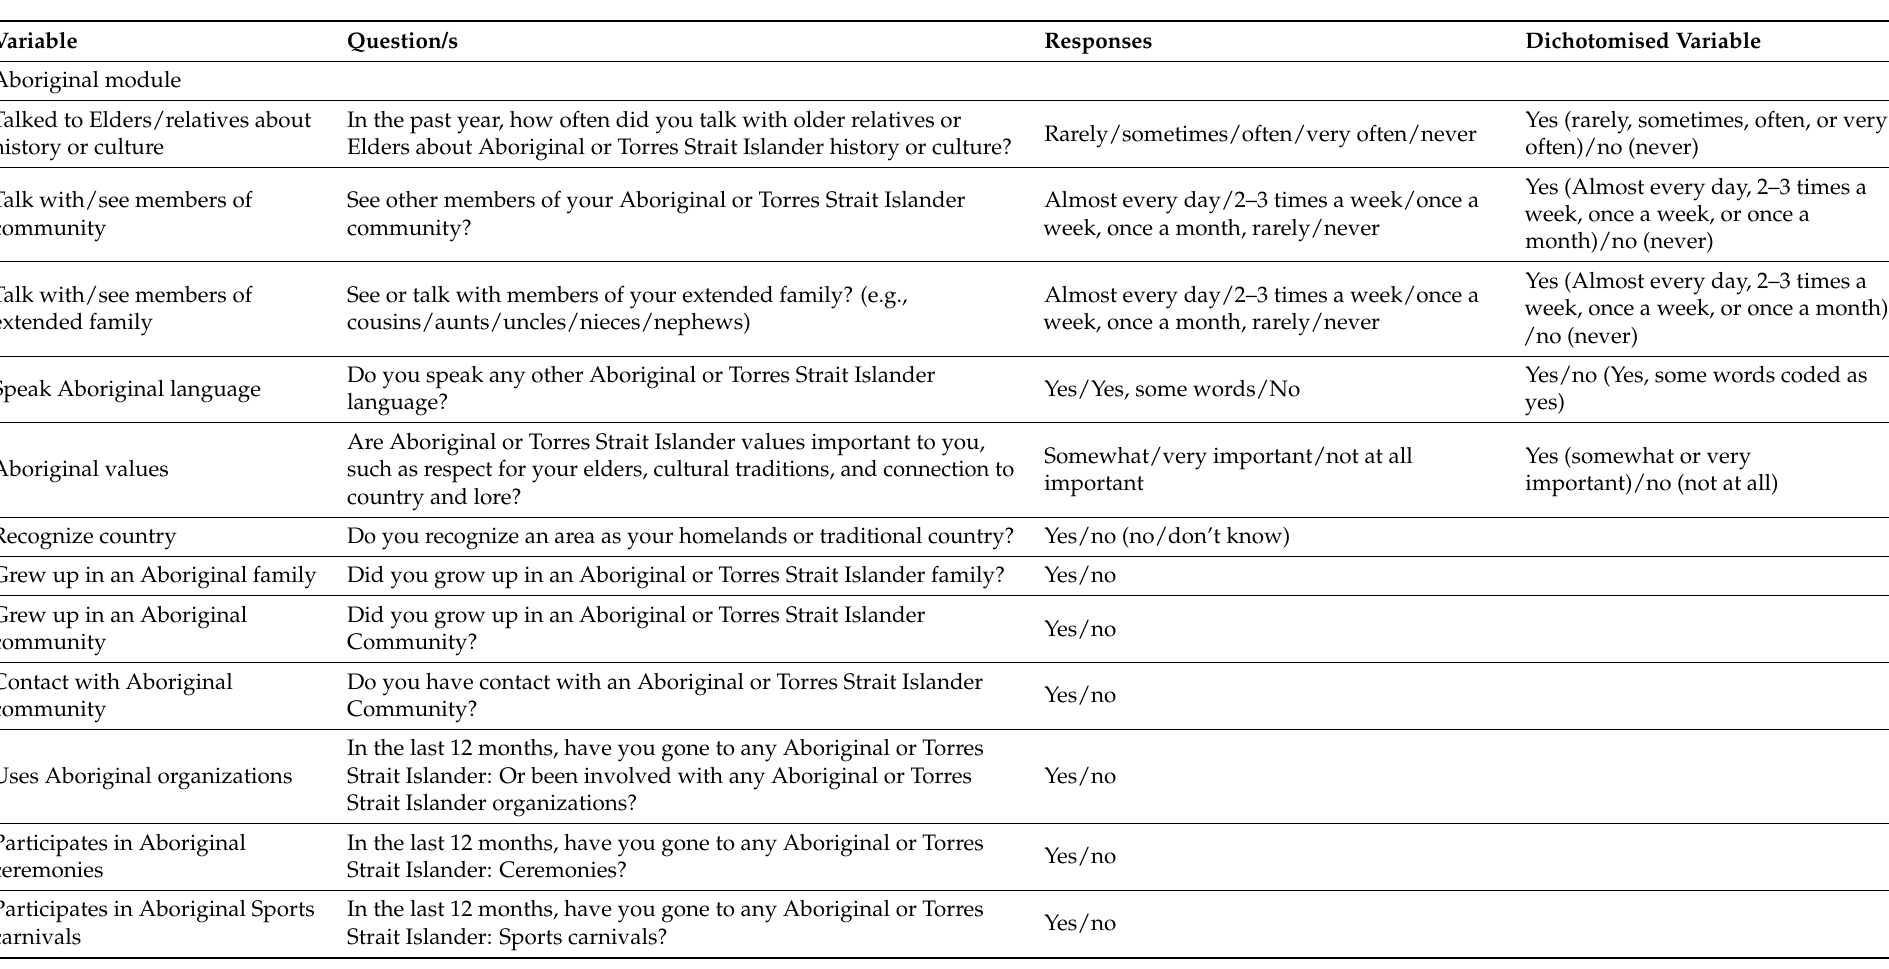
Table A1. Collection and measurement of cultural